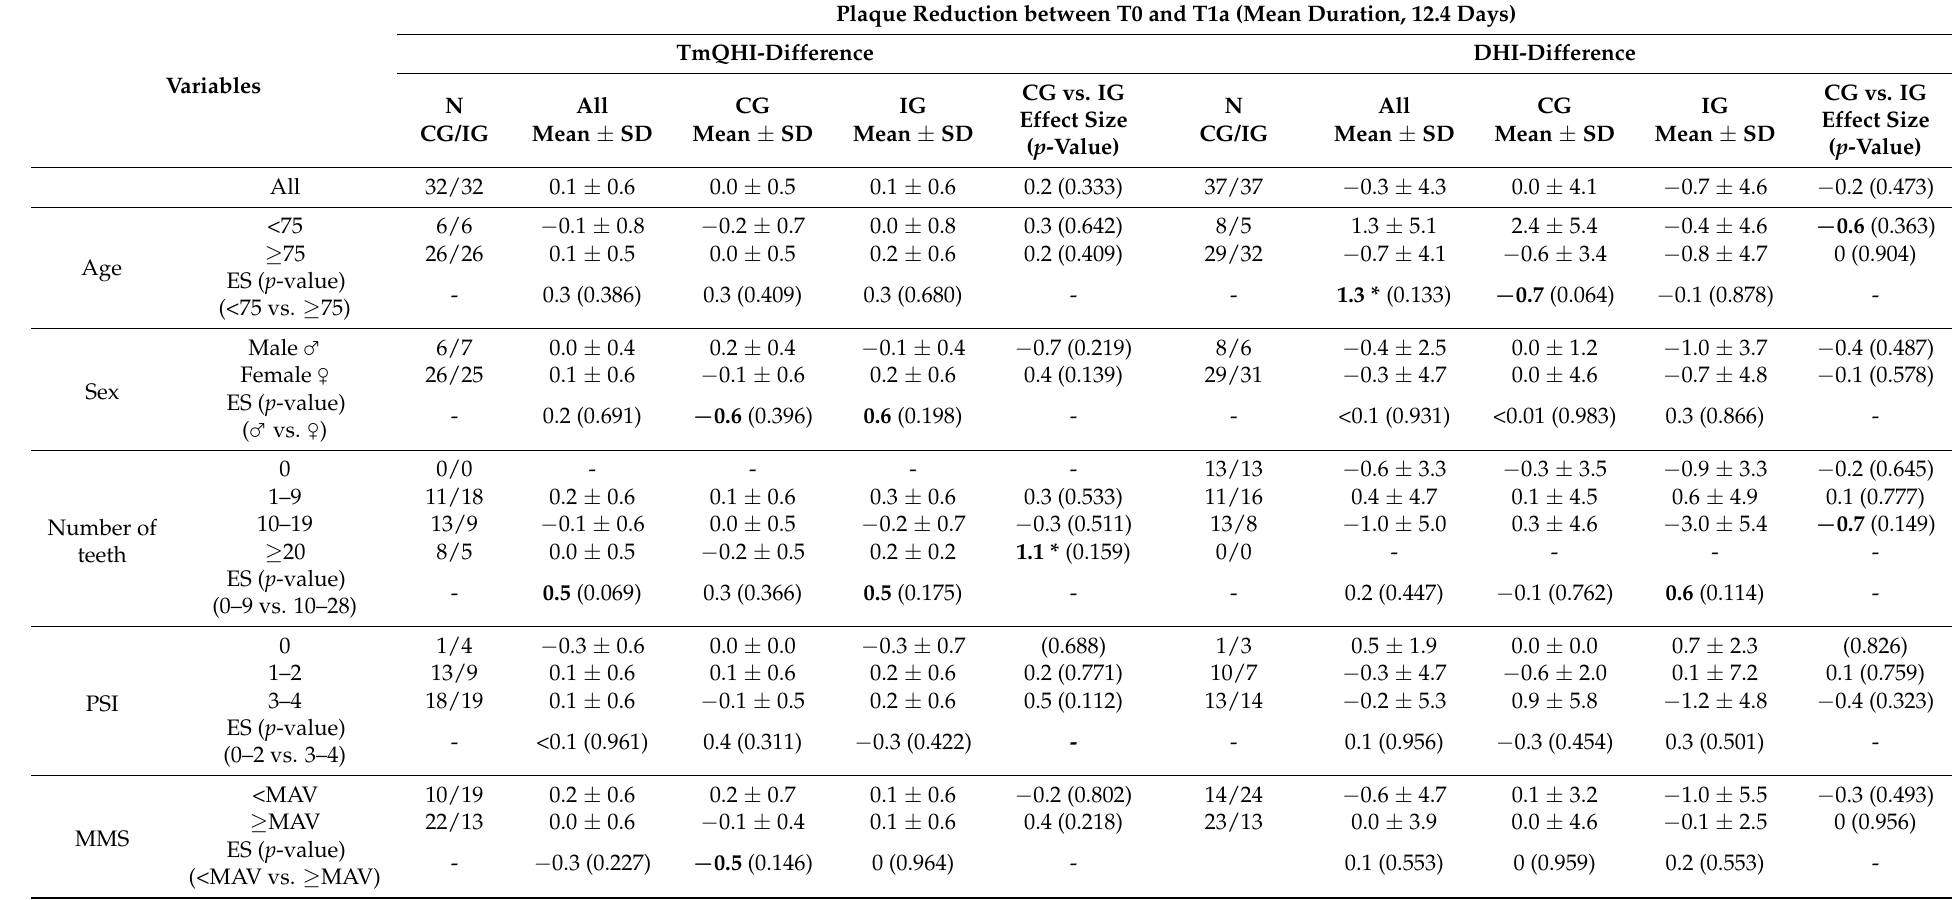
Table 3. Plaque reduction and effect of intervention measured by the TmQHI and DHI between T0 and T1a. Plaque Reduction between T0 and T1a (Mean Duration, 12.4